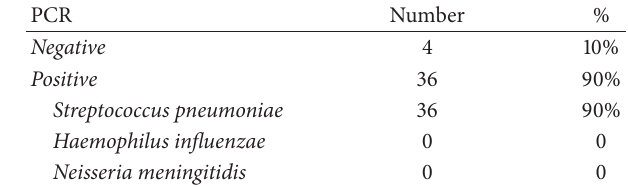
Table 3: Results of real-time PCR ( 𝑛 = 40